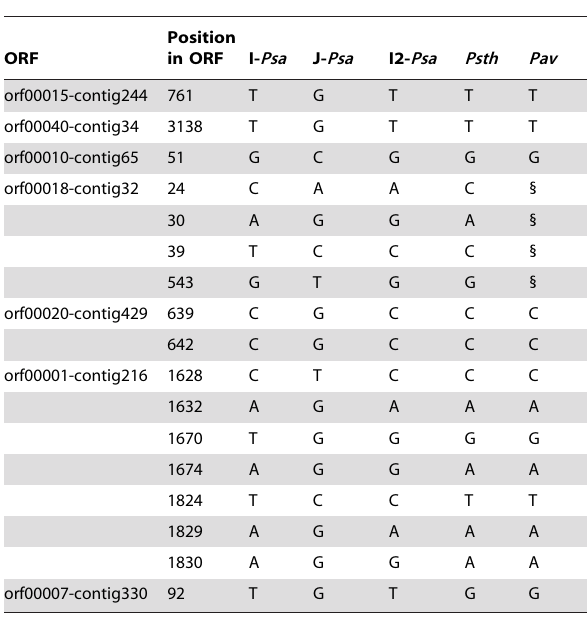
Table 4. Single Nucleotide Polymorphisms (SNP) found among the three Psa strains, P. avellanae BPIC631 and P. s. pv. theae NCPPB2598 draft genomes in the genes that were found polymorphic between I- Psa and J- Psa . ORF names refer to the I- Psa genome